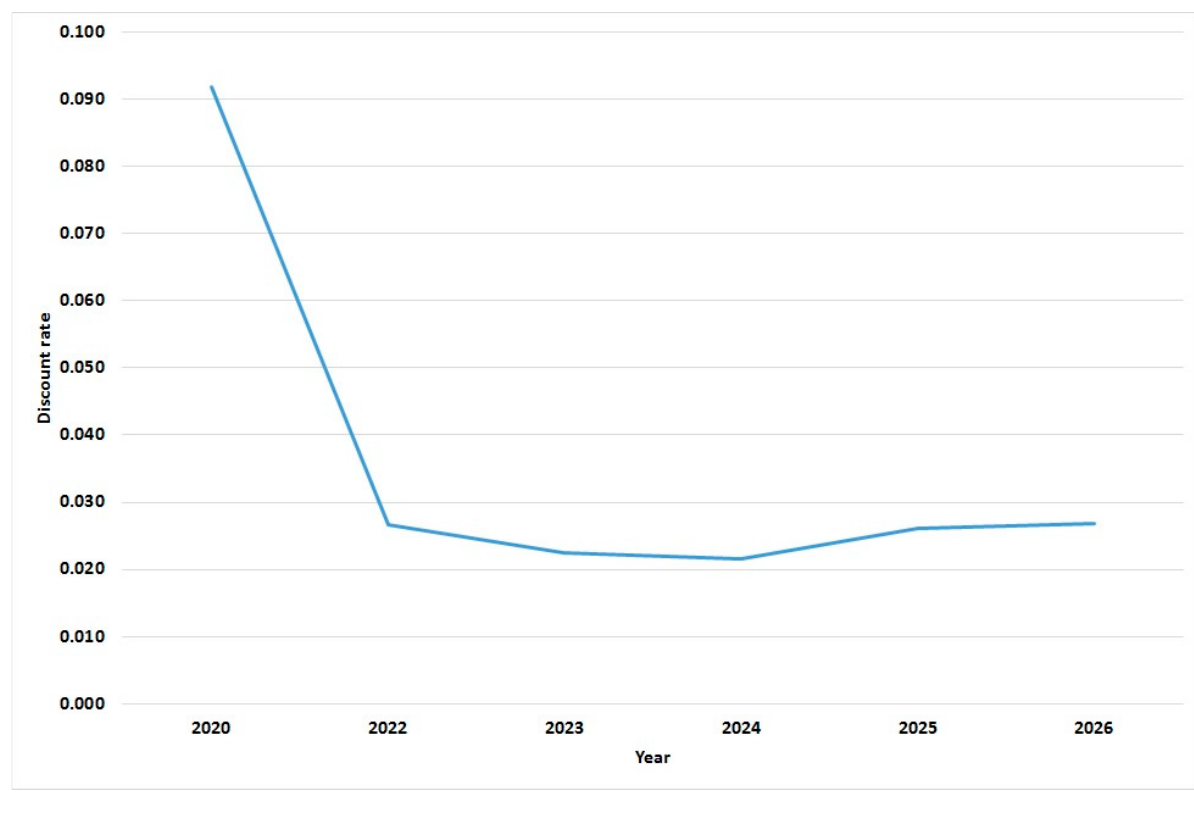
Figure 10. Discount rates for electricity prices.